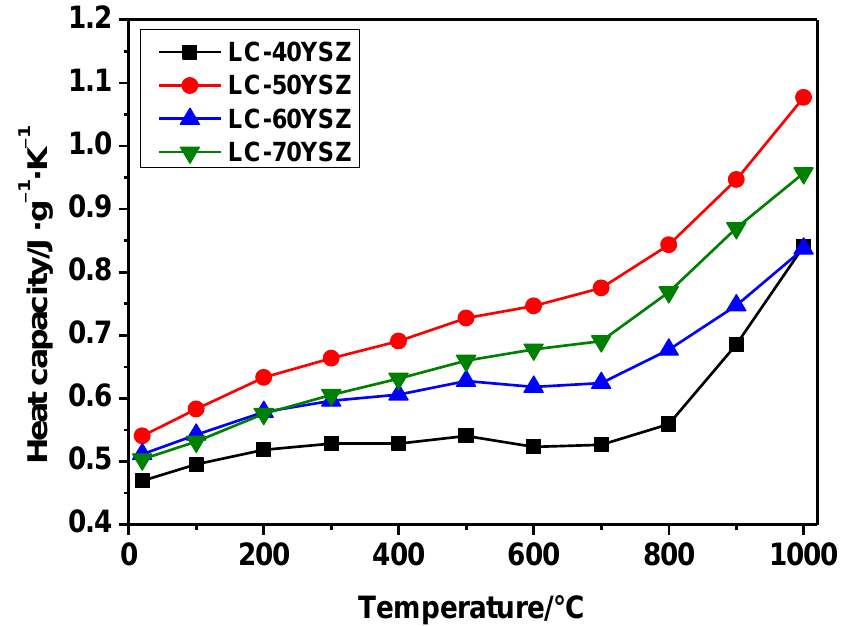
Figure 8. Temperature dependence of the specific heat capacities of the LC-YSZ composites.